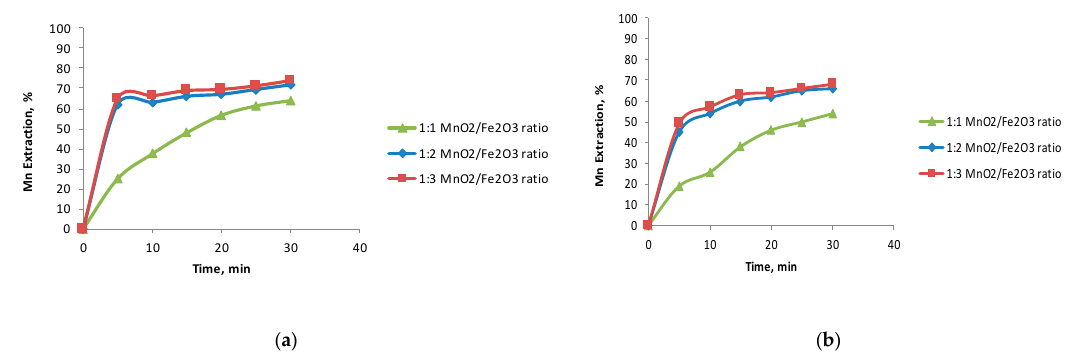
Figure 3. The effect of the iron oxide tailings concentration on MnO 2 dissolution ( a ) BSC-1; ( b ) BSC-2, 25 °C, particle size range of − 75–+53 µm, 1 mol/L H 2 SO 4 .